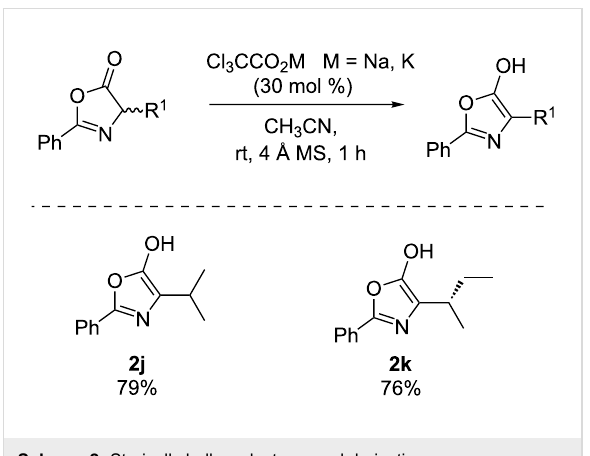
An interesting observation was found when employing azlac- tones derived from more sterically bulky amino acids, such as valine or isoleucine. In this case, the dimerization process does not occur. We isolate the corresponding azlactone enol deriva- tives 2j and 2k , which are very stable and unreactive species (Scheme 2)